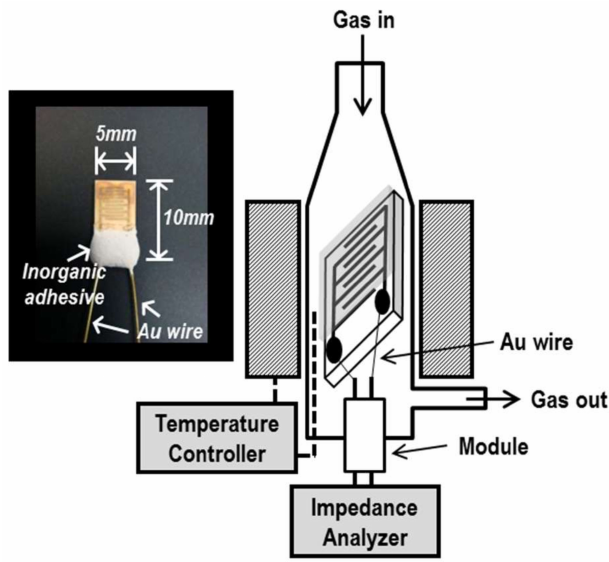
Figure 2. Schematic diagrams of the measurement apparatus and the actual image of the oxide thin-film